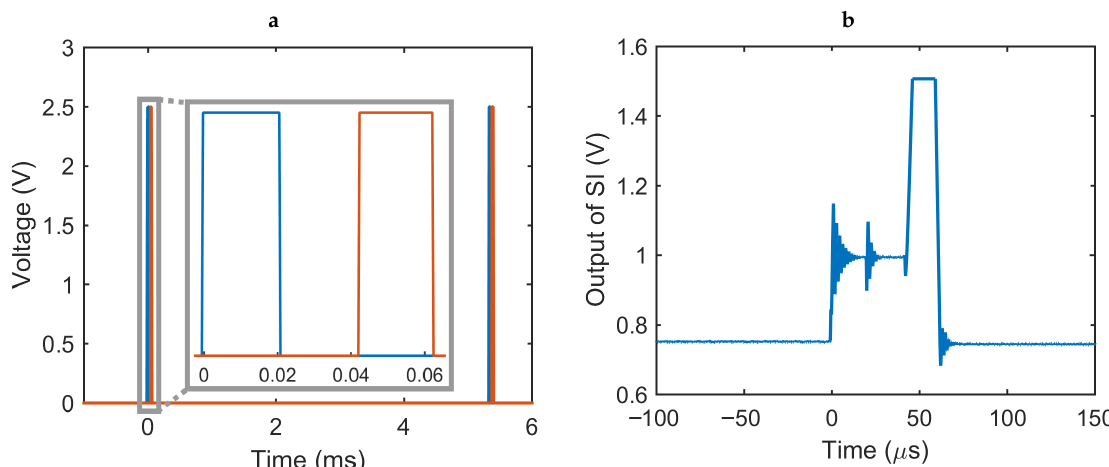
Figure 5. ( a ) The control signals generated by the microcontroller repeating every 5.3 ms. The inset shows SI_RST (blue) and SI_EN (orange) used for operating switches S2 and S1, respectively. ( b ) Measured output of the switched integrator showing the instant when switch S2 resets the feedback capacitor and switch S1 enables the integration of the photocurrent immediately after